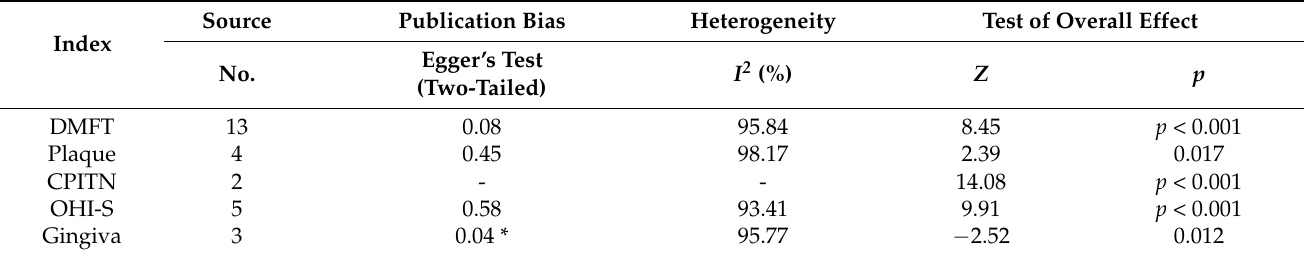
Figure 2. The pool extracted data of oral health index among children. ( A ) DMFT index ( B ) Plaque index ( C ) CPITN index ( D ) OHI-S index ( E ) Gingiva index. The forest plot revealed the standard difference in means of DMFT index (0.4441), Plaque index (0.158), CPITN index (1.419), and OHI-S index (0.803) were higher in special needs children. NC: normal children. SNC: special needs children. Table 2. The publication bias and heterogeneity of pooled